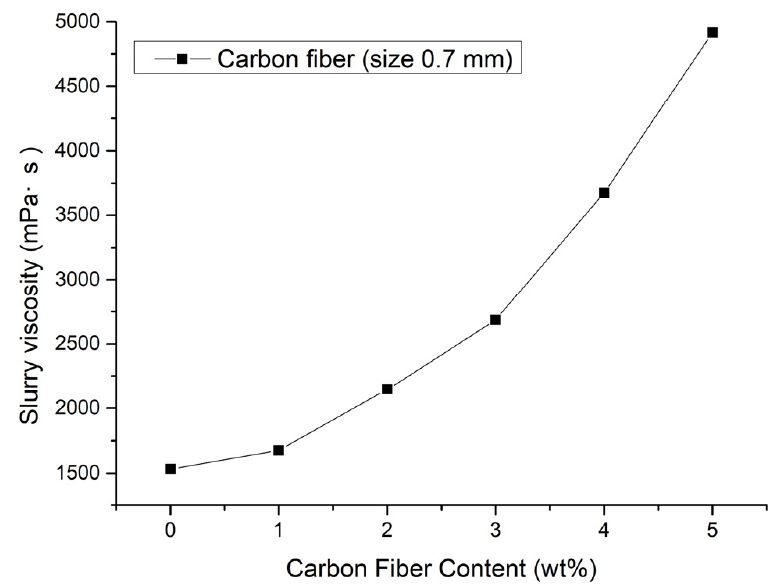
Figure 5. Variation of viscosity with carbon fiber content.